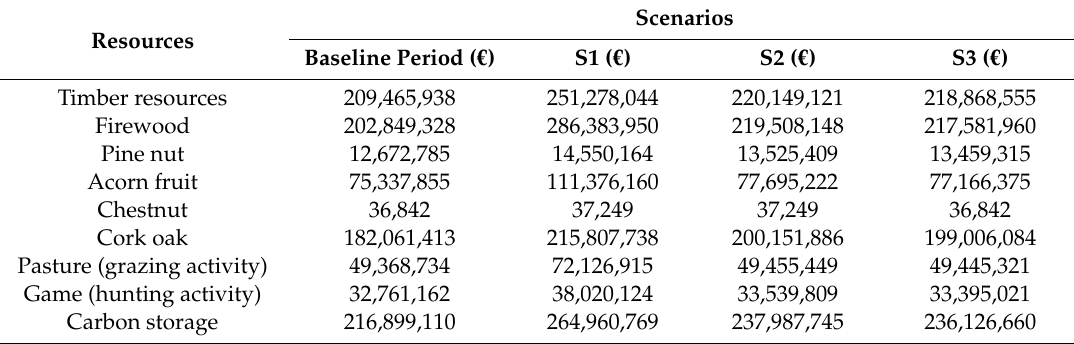
Table 6. Economic susceptibility of C ó rdoba province according to the baseline period and S1, S2 and S3